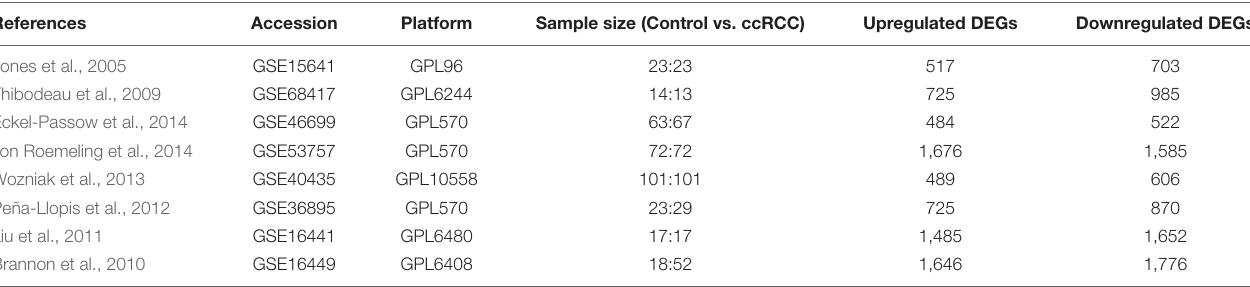
FIGURE 1 | Integrative analysis of multiple clear cell renal cell carcinoma (ccRCC) RNA sequencing datasets. (A) Flowchart of this study. (B) Heat map showing the top 20 shared upregulated (red) and downregulated (green) differentially expressed genes across all ccRCC datasets. The value in each cell represents log fold change (logFC) of the corresponding gene. RRA, robust rank aggregation. TABLE 1 | Details of the eligible ccRCC